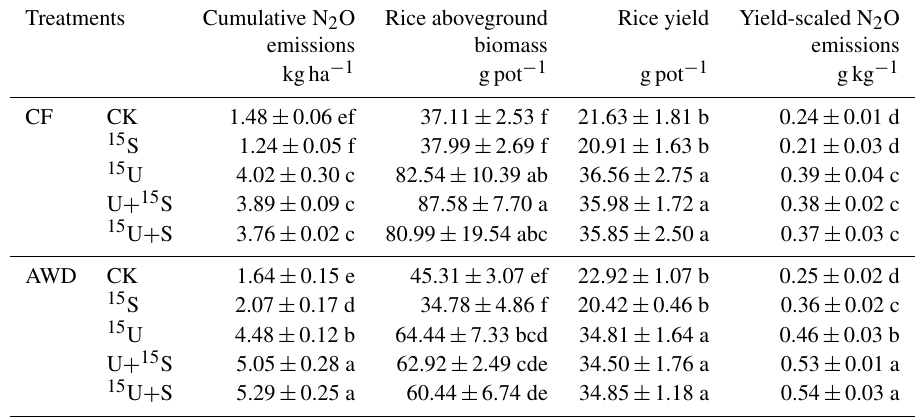
Table 1. Effects of different treatments on cumulative nitrous oxide (N 2 O) emissions, rice aboveground biomass, rice yield and yield-scaled N 2 O emissions. The values denote means ± standard errors ( n = 3). Different lowercase letters indicate significant differences ( P < 0 . 05).